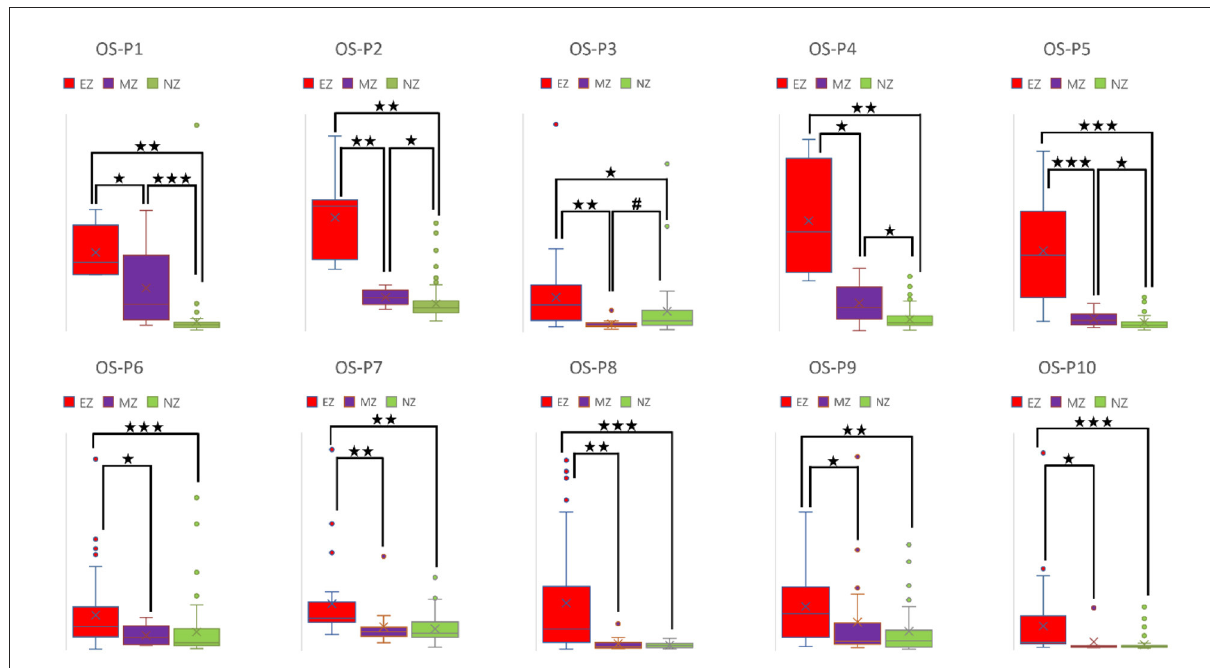
FIGURE6 Box plot of OS of all ten patients for EZ, MZ, and NZ (P1 represents patient 1; ⋆ represents p < 0.05 with EZ > MZ, EZ > NZ, or MZ > NZ; ⋆⋆ represents p < 0.001 with EZ > MZ, EZ > NZ, or MZ > NZ; ⋆⋆⋆ represents p < 0.00001 with EZ > MZ, EZ > NZ, or MZ > NZ; # represents p < 0.05 with EZ < MZ, EZ < NZ, or MZ < NZ; Mann-Whitney U test [two–tailed]). OS, out–strength; EZ, epileptogenic zone; MZ, margin zone; NZ, normal